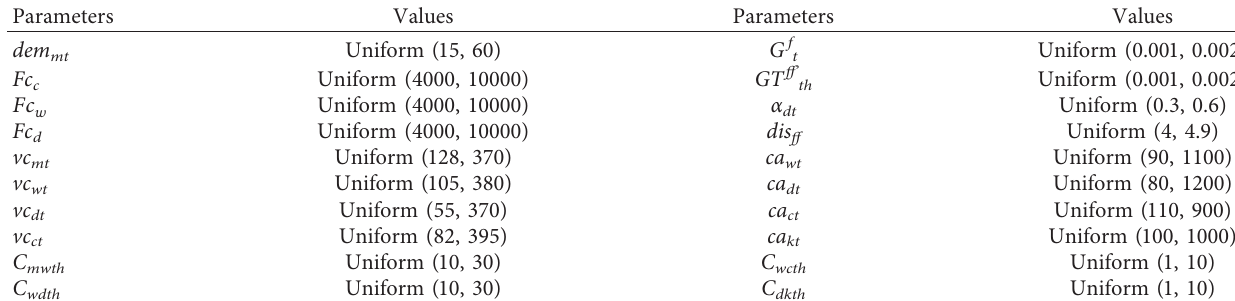
Table 3: Values of input parameters of the problem.